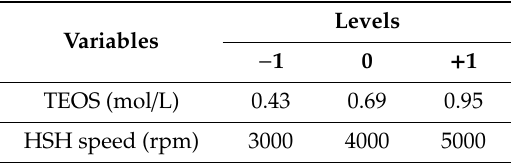
Table 1. The values for the lower ( − 1), central (0) and upper ( + 1) levels for the variables investigated in the 2 2 full factorial design for the synthesis of silica nanoparticles (SiNP). (TEOS, tetraethyl orthosilicate; HSH, high shear